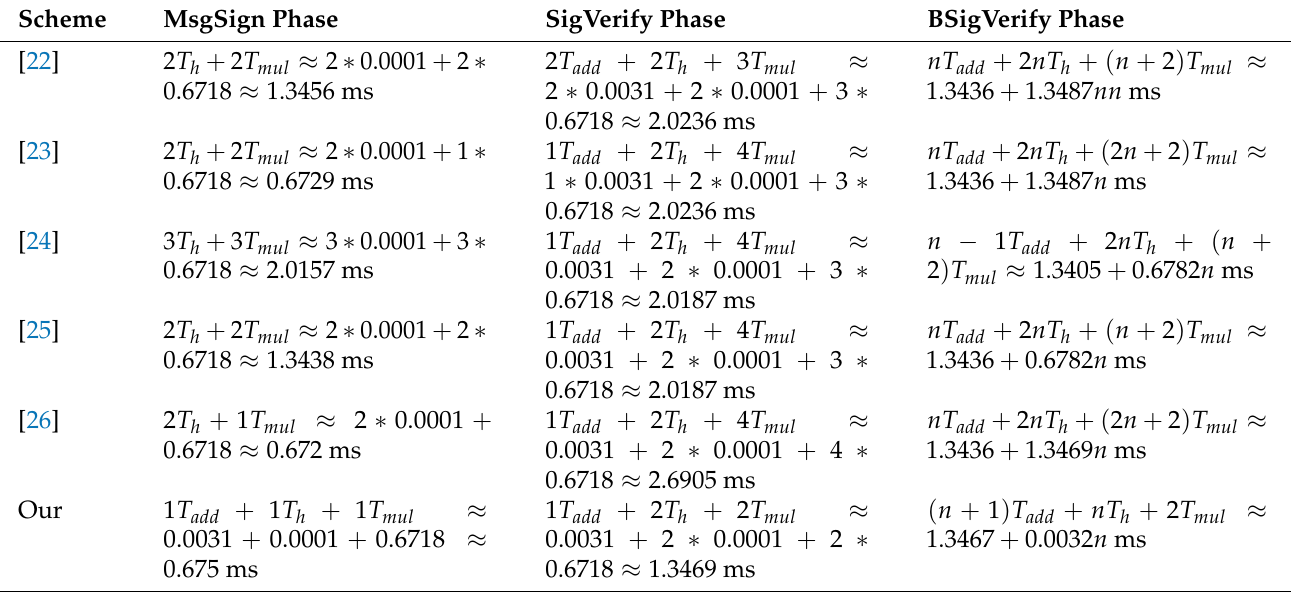
Table 3. The Cost of Computation of Authentication